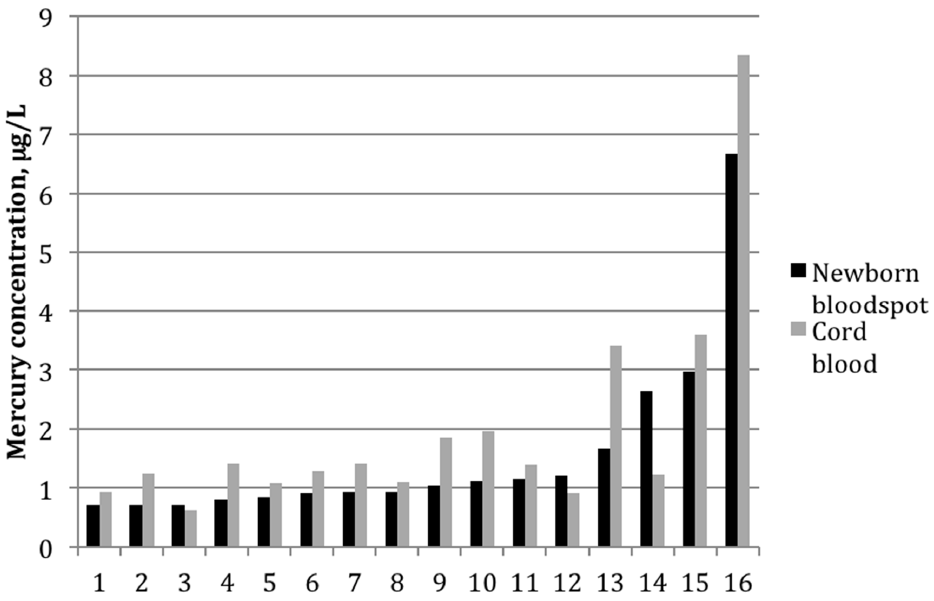
Figure 2. Mercury concentrations ( μ g/L) for each mother-infant pair in which mercury was detected in both cord blood and newborn bloodspot ( n = 16).